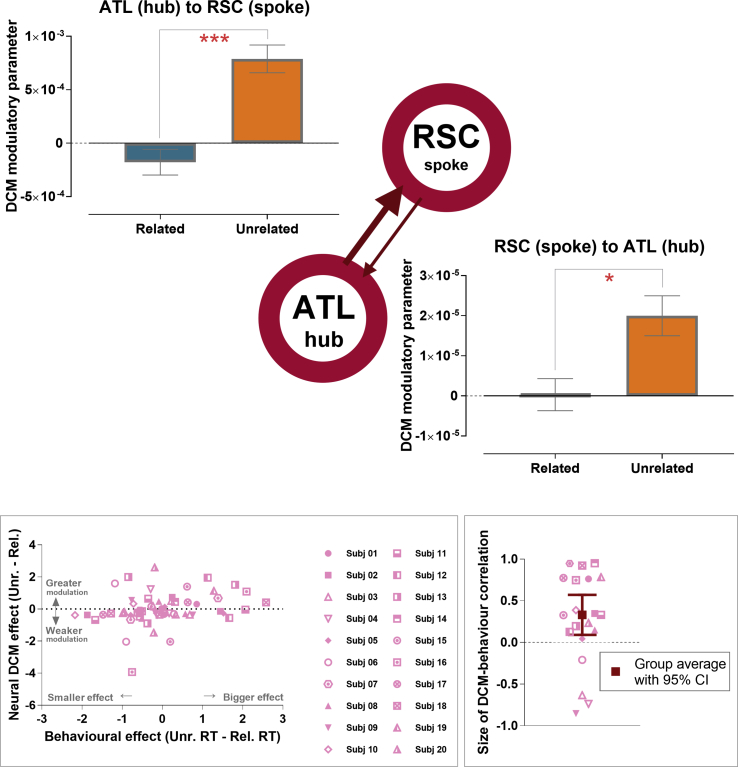
Experiment 2: Analysis of DCM on the modulatory coupling between the ATL hub and place-related spoke (the retrosplenial cortex). The two bar-charts show the magnitude of modulatory coupling parameters by directionality (hub-to-spoke, spoke-to-hub) and contexts (related, unrelated). The thickness of arrow in the diagram depicts the outcome that the hub-to-spoke connection was more modulated by contexts. Below the diagram: (i) The left inset-box describes the size of behavioural congruency effect (the difference in RT of related vs. unrelated context) in relation to the effect at neural level (the difference in DCM modulatory parameters, related vs. unrelated). This contains 60 data-points (20 participants × 3 runs of scanning). For illustrative purpose, the values are normalised, transformed to standard Z-scores. (ii) The right inset-box describes the values of DCM-behavioural correlation. This contains 20 data-points; each represents an individual's correlation across scanning runs. Note that the group's average is significantly above the chance level (no correlation).